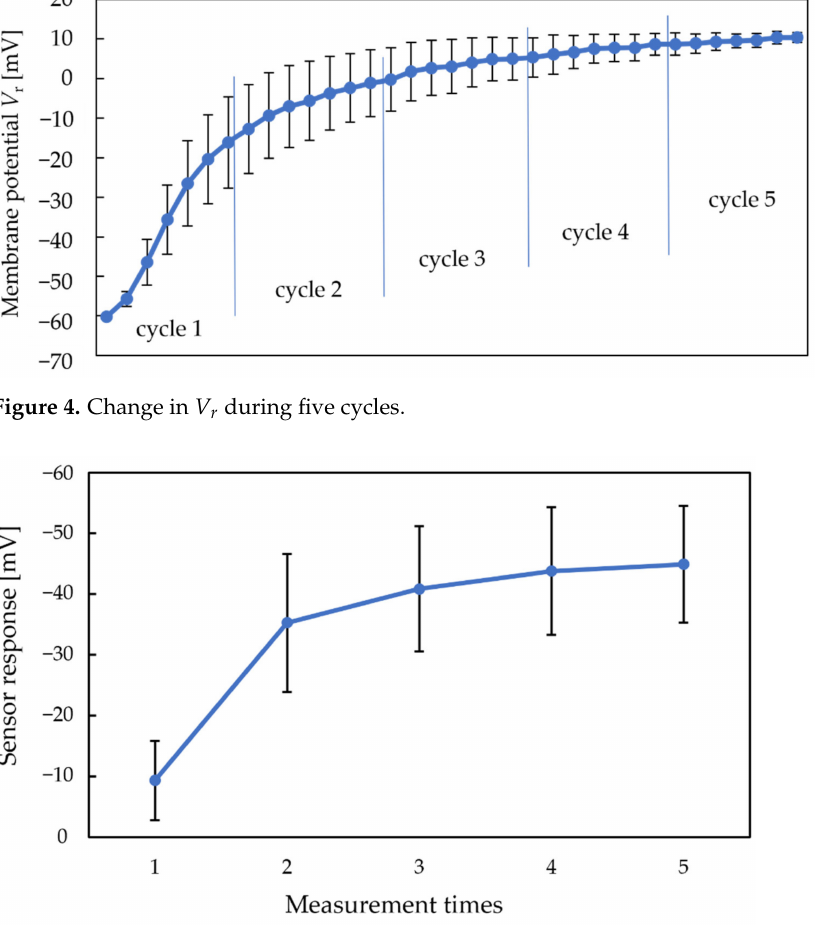
Figure 5. The sensor response to 300 mM sucrose by using conventional conditioning